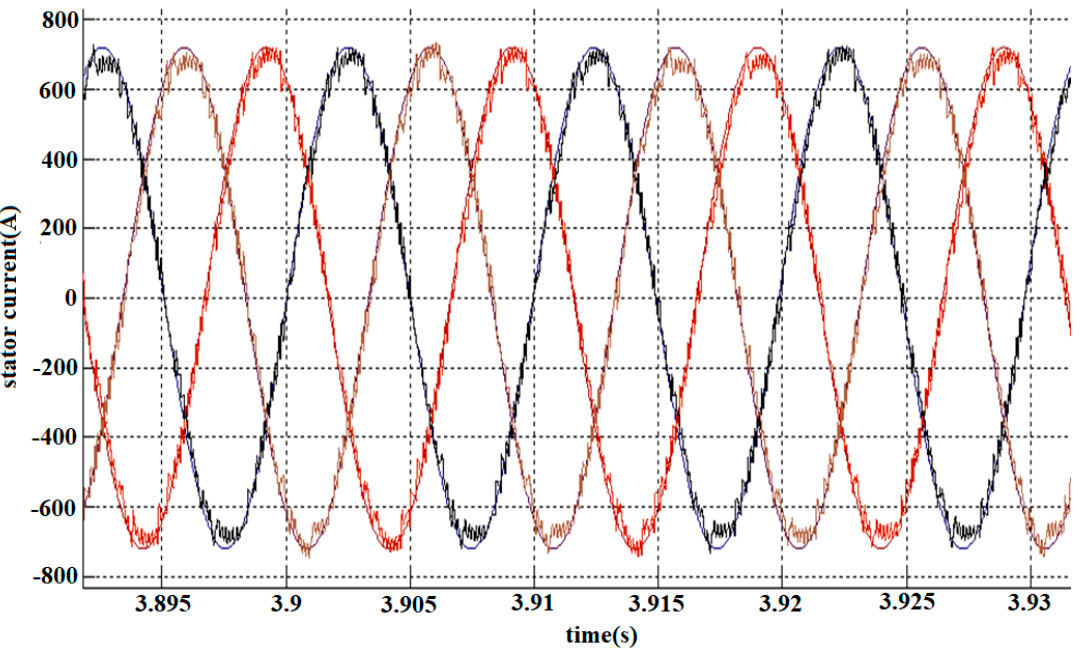
Figure 27. Tracking of stator current of the motor.